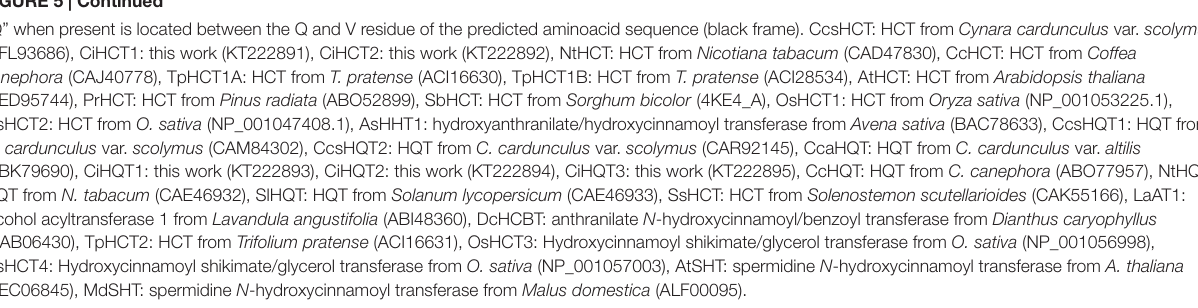
Frontiers in Plant Science |